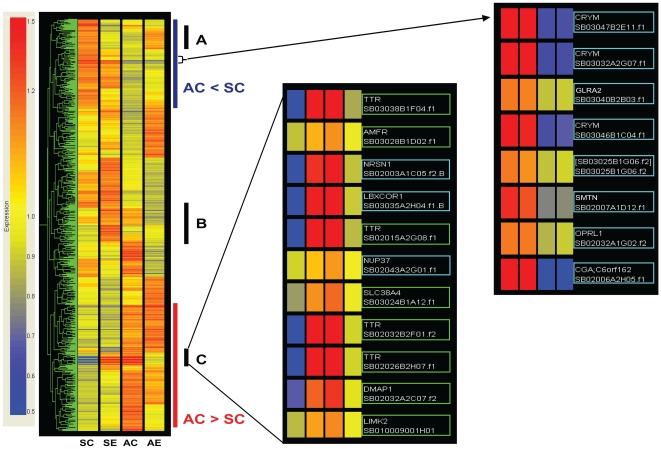
Hierarchical clustering of all differentially expressed cDNA spots.All cDNA spots that passed the cut-off (p<0.01) in the cell-means model (total of 727 genes) were clustered using Pearson correlation and shown as a heatmap. Up-regulated cDNAs are shown in red, down-regulated cDNAs are shown in blue compared to a mean of all four groups. Examples of two distinct groups are seen in AC vs. SC comparison (blue and red line; down- and up-regulation, respectively). Those cDNA spots affected by interactions are also shown as sections (A, B, C). Portion of AC<SC and section C of the interaction are magnified as a representation of cDNA spots (middle and right panel). Those cDNAs highlighted made cutoff in each comparisons (squared in green with interaction effect, blue with AC vs. SC). Clustering of different cDNA spots of the same gene (TTR and CRYM) shows consistency of expression patterns among these cDNAs.